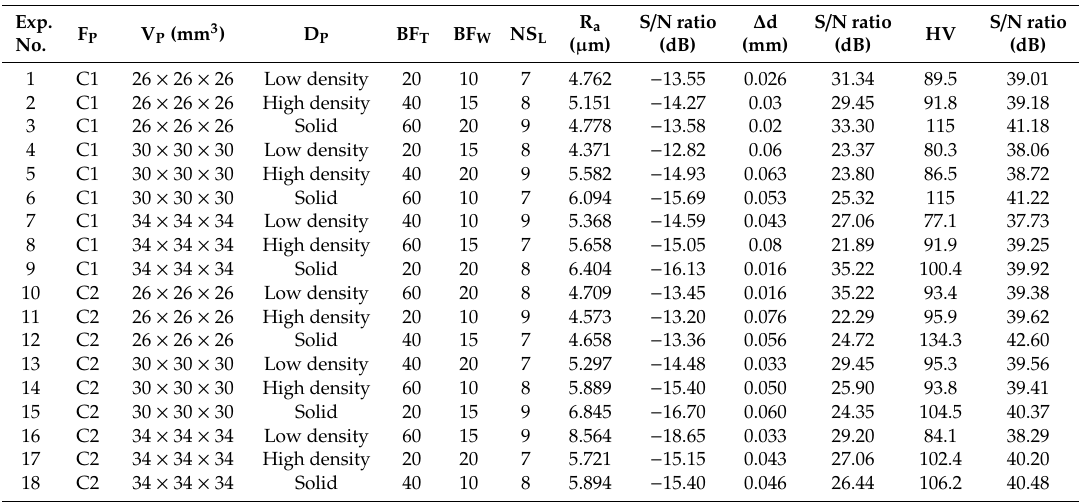
Table A1. Design of experimentation as per original Taguchi L18 orthogonal